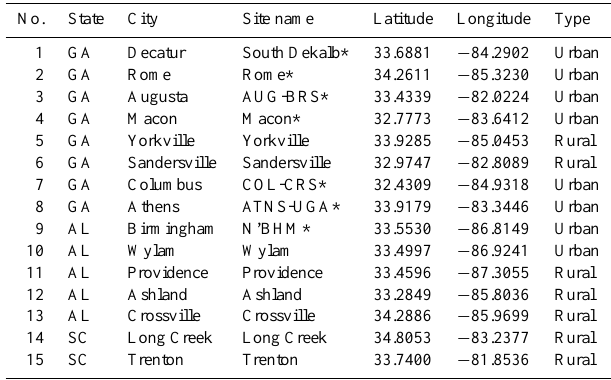
Table 1. Locations and types of the FRM sampling sites in this study.